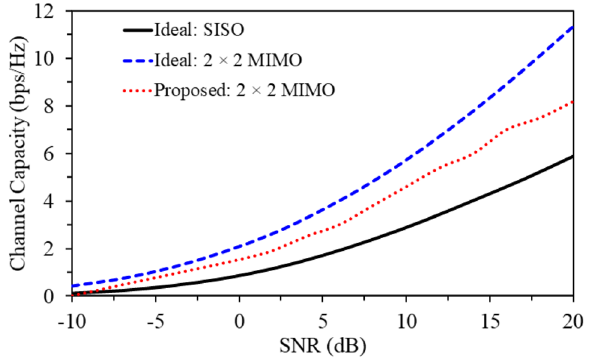
Figure 15. CC versus SNR for the wideband implantable MIMO antenna with three different systems (SISO, ideal MIMO, and proposed MIMO).